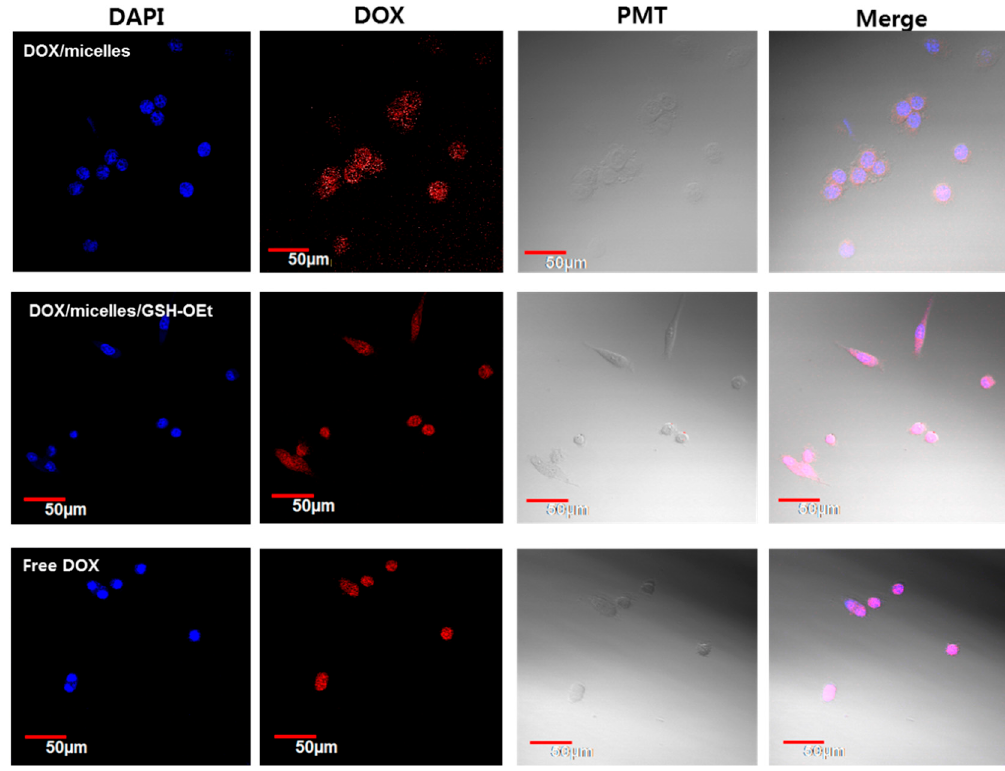
Figure 9. Confocal laser scanning microscopy (CLSM) images of KB cells pretreated with or without glutathione reduced ethyl ester (GSH-OEt) and then incubated with free doxorubicin (DOX) and DOX-loaded Chol-ss-PEG-ss-Chol micelles for 3 h. From left to right: DAPI staining, DOX fluorescence in cells, photomultiplier tube (PMT) images, and overlays of both.